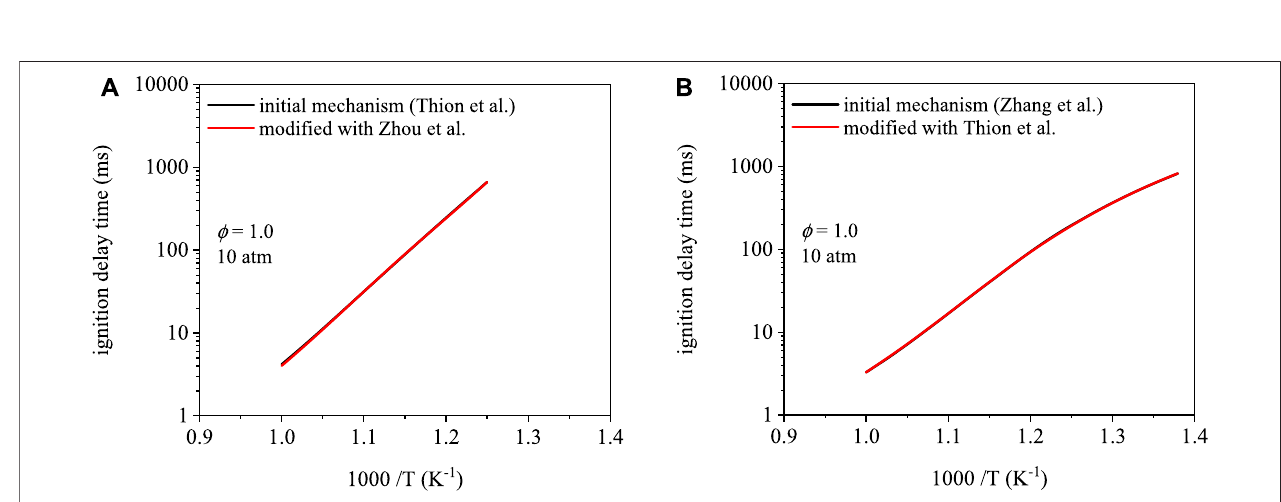
FIGURE 5 | Ignition delay time simulations for cyclopentanone: (A) Thion et al. (Thion et al., 2016) mechanism, (B) Zhang et al. (Zhang et al., 2019) mechanism. Modi fi cations to each mechanism result in indiscernible ignition delay time predictions.